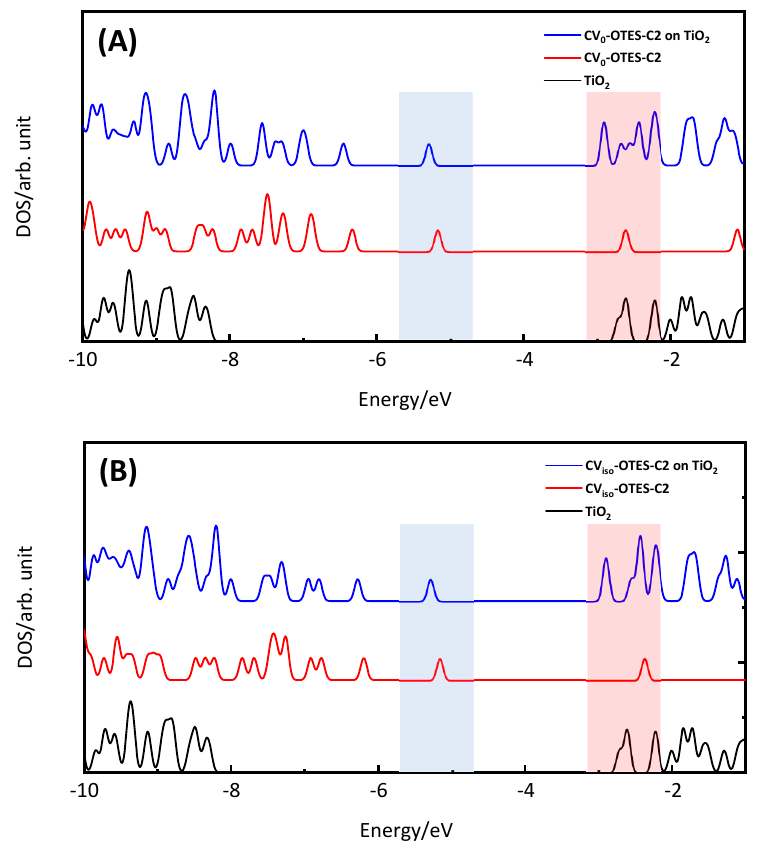
Figure 9. Density of state (DOS) spectra of ( A ) CV 0 –OTES–C2 and ( B ) CV iso –OTES–C2 adsorbed on the TiO 2 cluster using CPCM in EtOH. Black, red and blue lines correspond to the TiO 2 cluster, isolated CV–OTES–C2 and CV–OTES–C2 adsorbed on the TiO 2 cluster. Blue and red bars indicate the HOMO and LUMO.